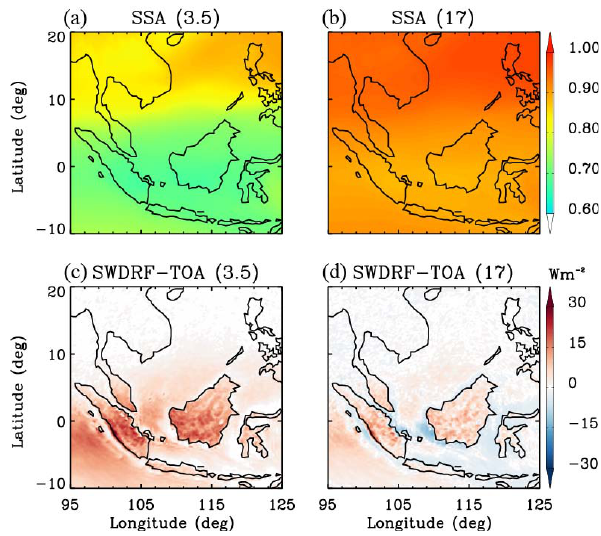
Fig. 8. Distribution of monthly averaged variables in October 2006 for (a) single-scattering albedo (SSA) in 600nm, (c) SWDRF with OC/BC ratio 3.5, (b) and (d) are same as (a) and (c) but with OC/BC ratio